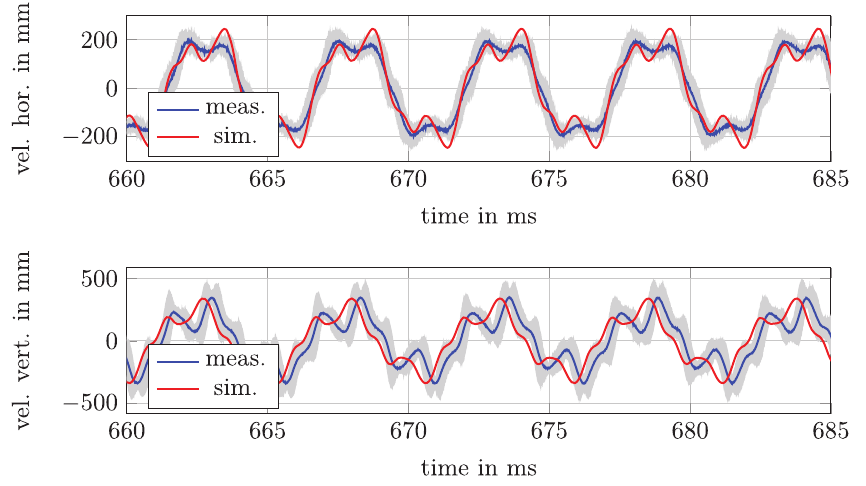
Figure 15. Velocity of experiment (blue) and simulation (red) in comparison after 660 ms. The string is measured 15 mm beside the